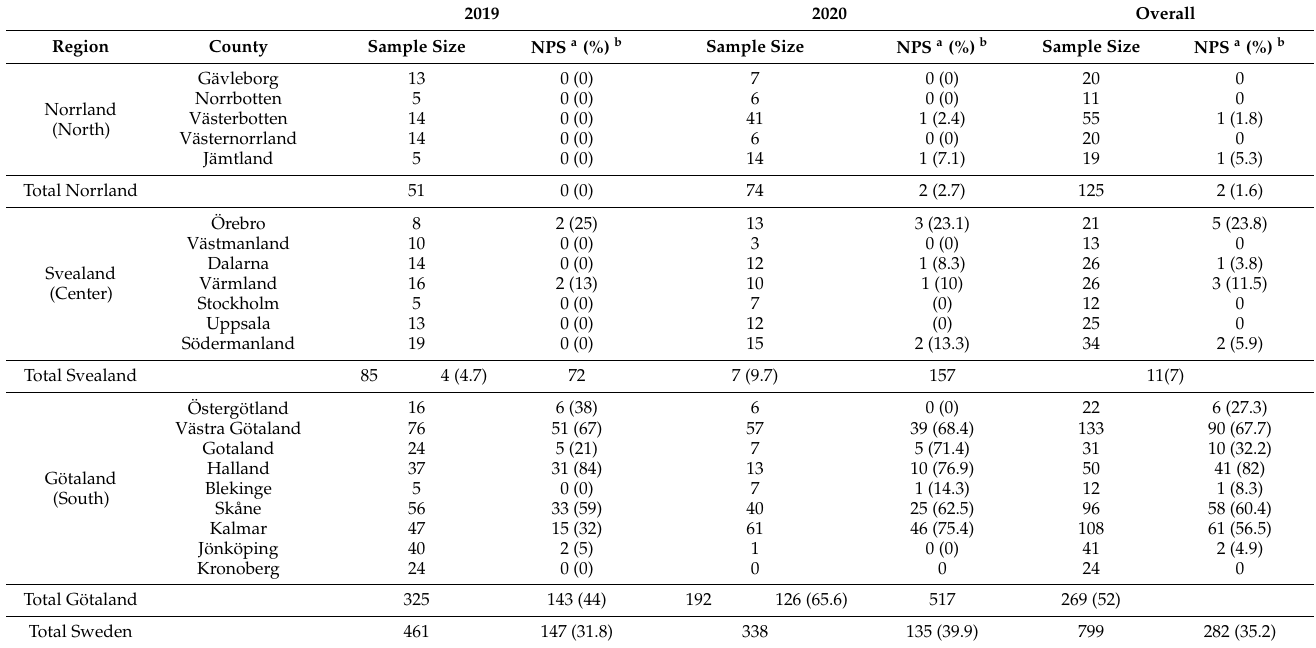
(Table 1). No IDV-specific antibodies were detected in Norrbotten (Norrland), Gävleborg (Norrland), Västernorrland (Norrland), Västmanland (Svealand), Stockholm (Svealand), Uppsala (Svealand) or Kronoberg (Götaland). Counties located in the southern region of Sweden (Götaland), and in particular in the county of Halland, had the highest proportion of antibody-positive samples (84% and 77% in 2019 and 2020, respectively, Table 1, Figure 1). Whereas the proportion of positive samples increased by 22% between 2019 and 2020 in the southern region, it increased by only 8.1% in the country. Table 1. Sample size, number and proportion of herds with IDV-specific antibody in bulk tank milk in different Swedish counties.